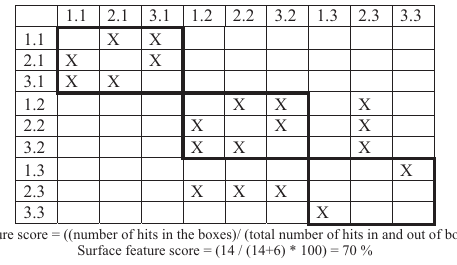
FIG. 5. An example of a surface feature matrix for a novice student sorting cards based mostly upon surface features.